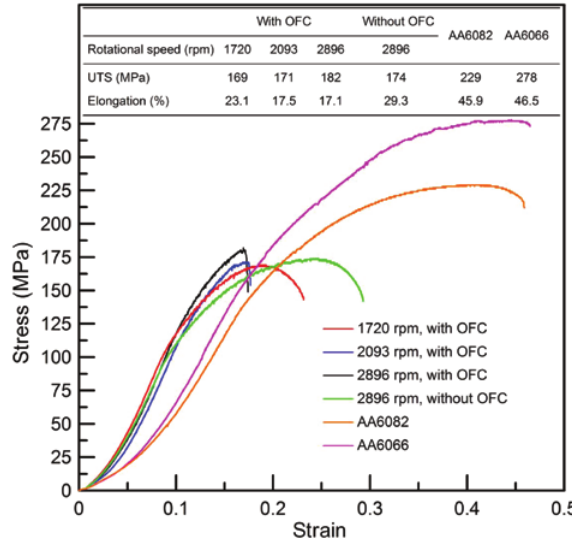
Figure 10: XRD analysis taken from the stir zone of the dissimilar metal FSW joints.